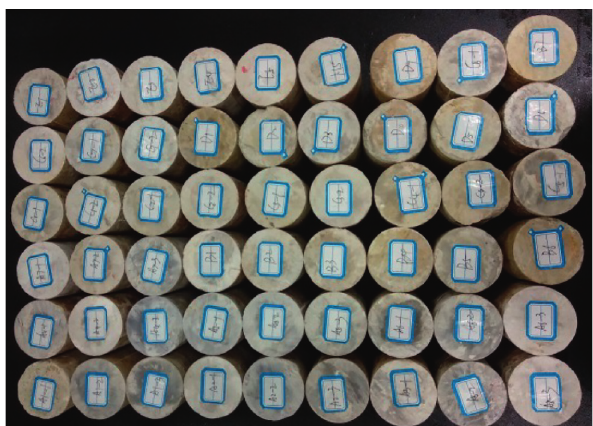
Figure 1: Standard samples of similar materials with different contents of nanometer.